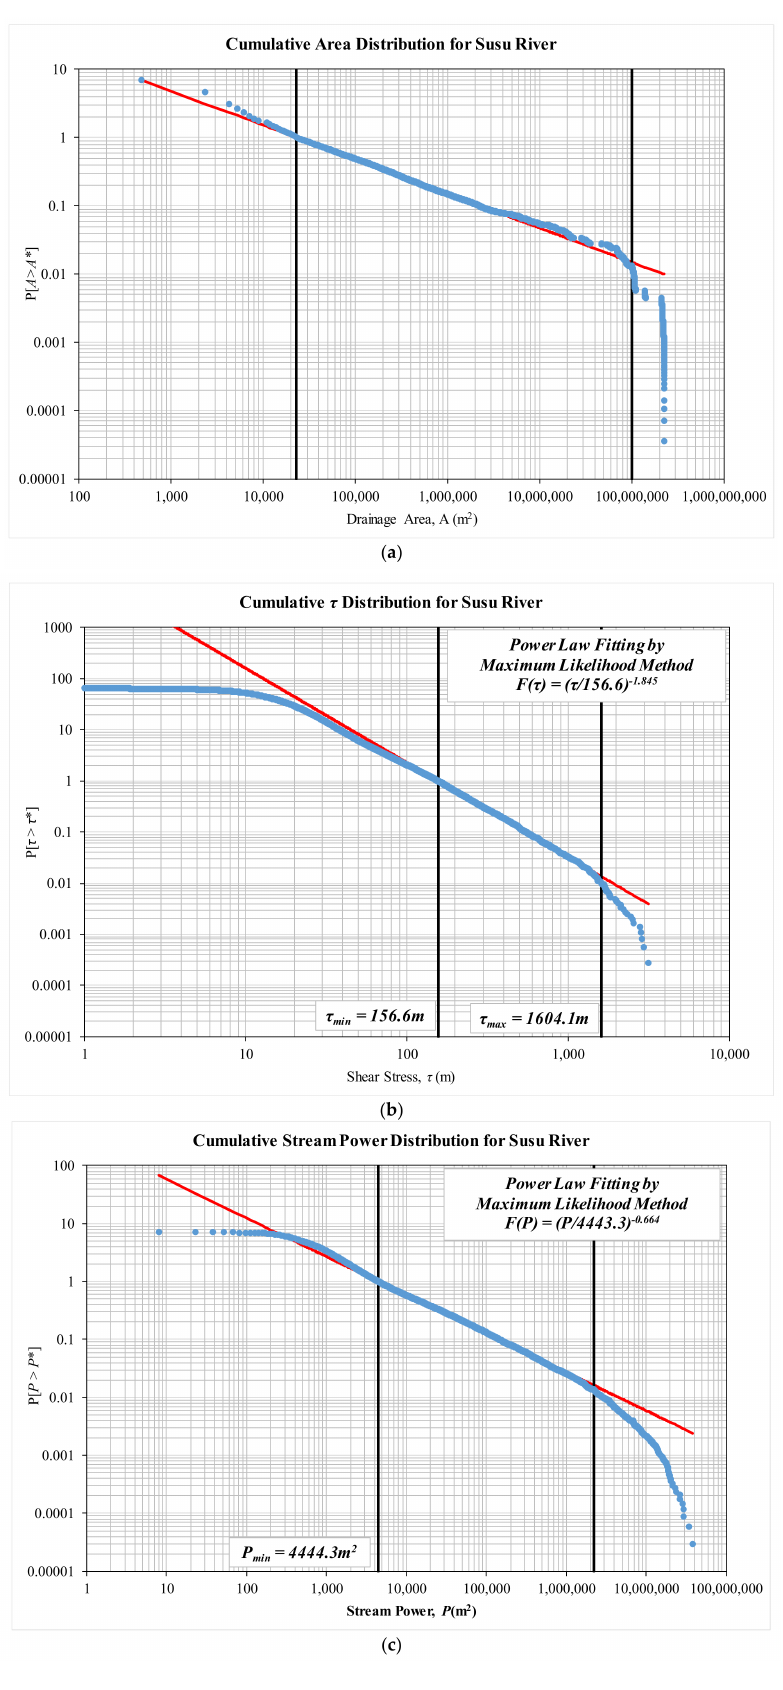
Figure 4. Power law distributions of geomorphologic factors for the Susu River Basin: ( a ) drainage area; ( b ) shear stress; ( c ) stream